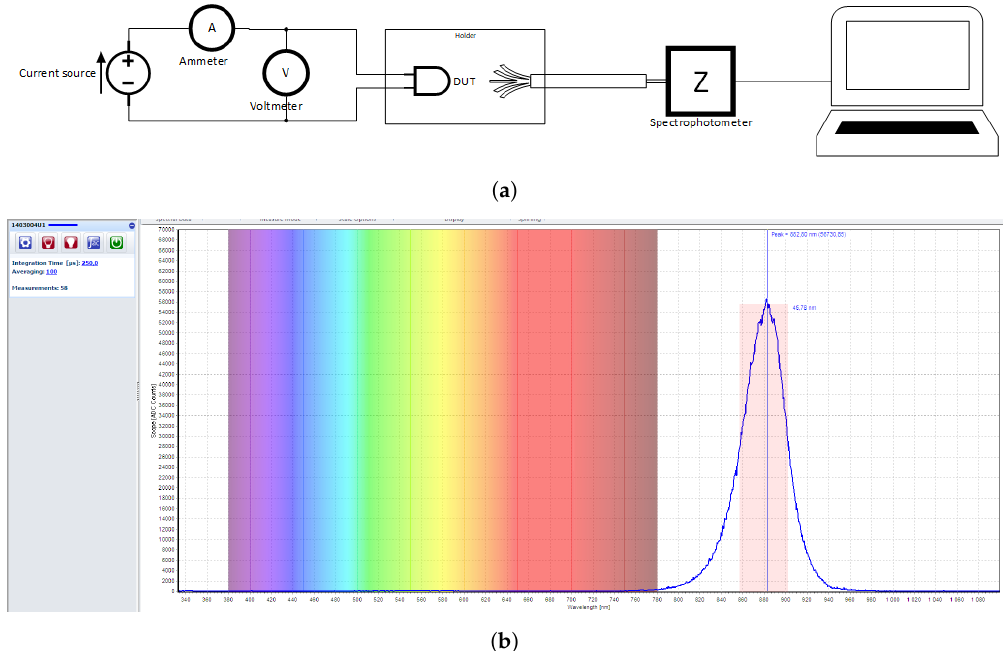
Figure 5. ( a ) Experimental measurement diagram of the setup used for spectra collection, ( b ) Screenshot of an emission spectrum visualized through the software Avasoft with live identification of the full width at half maximum (FWHM) and the peak